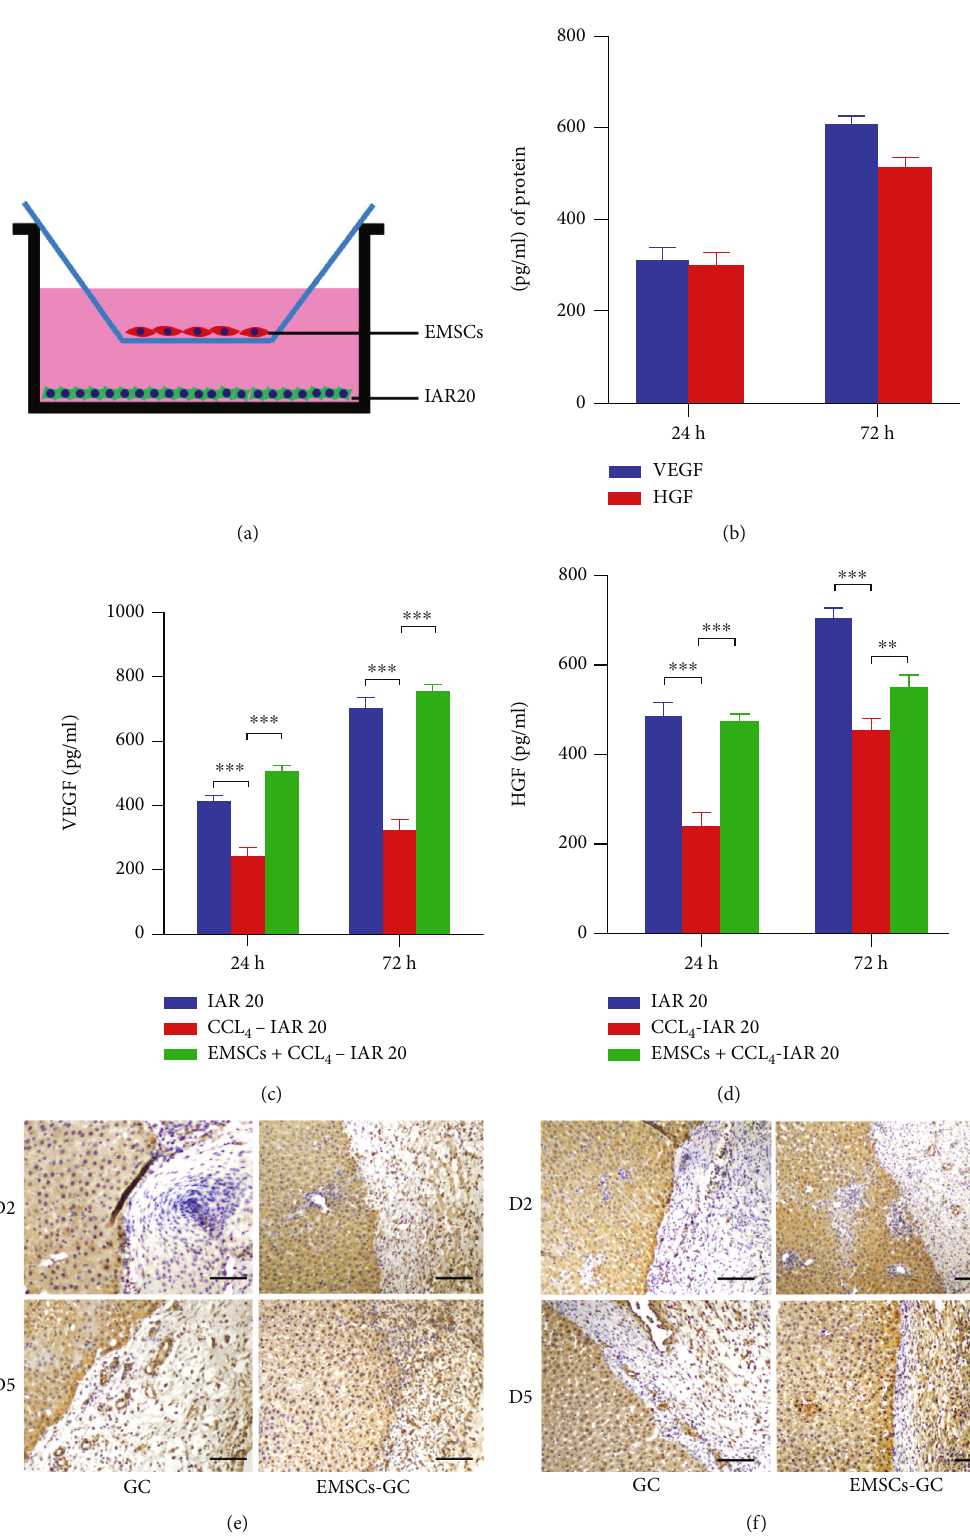
Figure 5: EMSCs protected CCl -induced hepatocyte injury by secreting VEGF and HGF in vitro and in vivo. (a) Schematic illustration of 4 coculture assay. (b) Secretion of VEGF and HGF in the culture media of EMSCs. (c, d) EMSC coculture signi fi cantly increased VEGF and treatment group. (e, f) Immunohistochemical examination of VEGF (e) and HGF (f) expressions in vivo. HGF levels compared to the CCl 4 Scale bar = 200 μ m